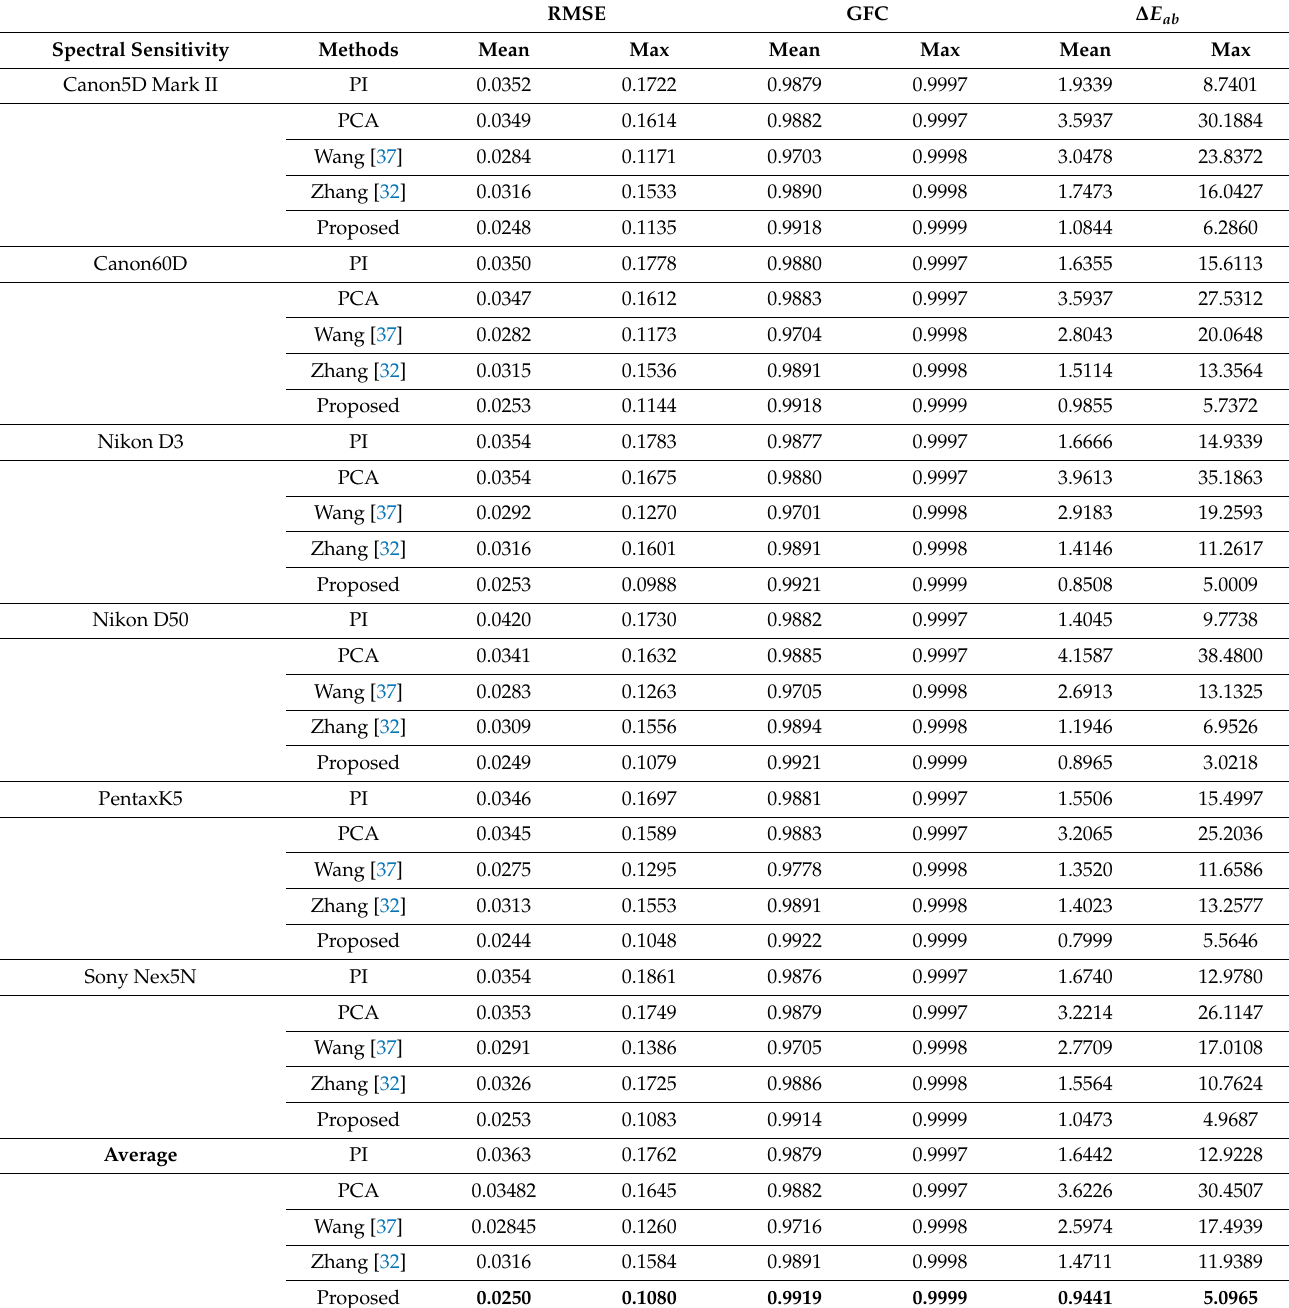
Table 6. Results of recovery spectral reflectance for different spectral sensitivity functions using different spectral recovery